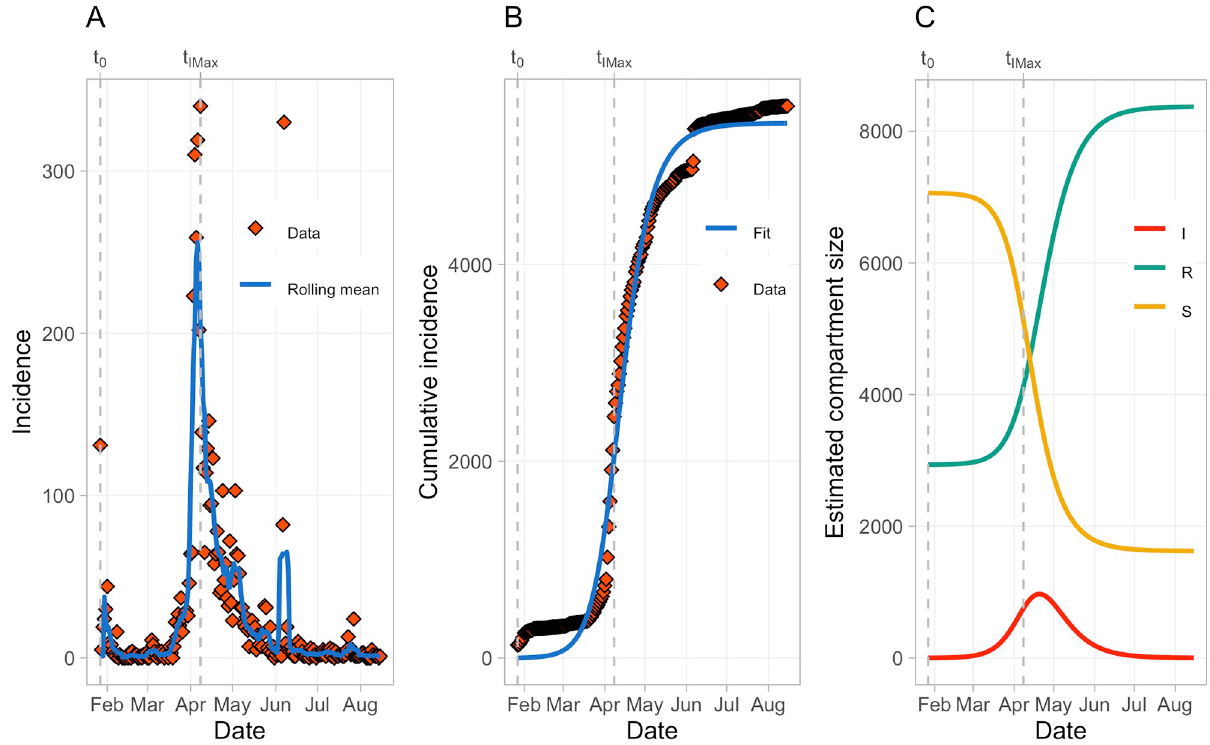
Fig 1. Acceptable correspondence of observed and predicted hashtag incidence. (A) Hashtag incidence over time. Please note that “Rolling mean” refers to the simple moving average with the rolling window k = 7. (B) Best basic SIR model fit. (C) Model predictions of the compartment sizes over time.